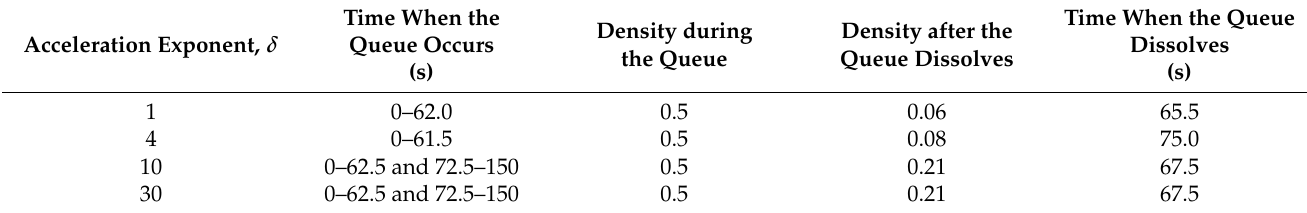
m circular road: ( a ) ; ( b ) 1800 𝛿𝛿 = 1